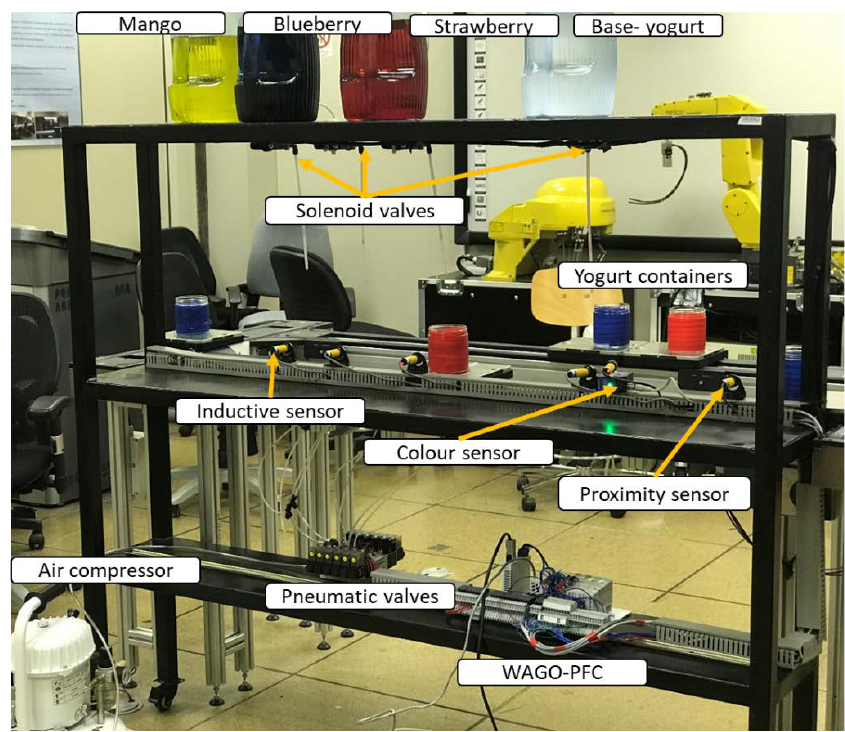
Figure 7. Designed smart production plant/system design and implementation. Figure 6. Designed smart production plant / system design and